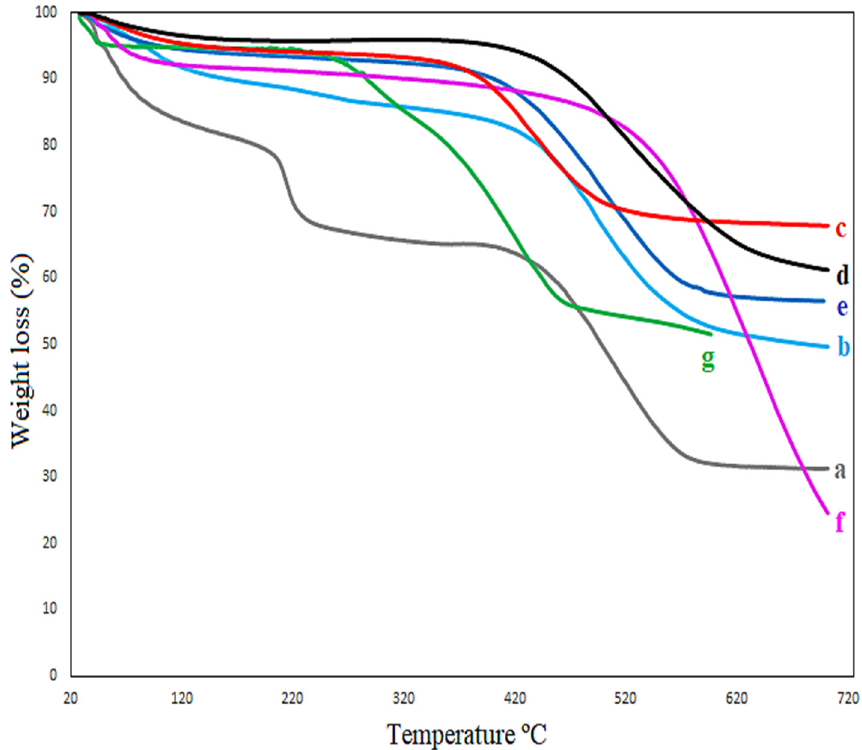
Figure 5. TGA analysis of activated carbon ( a ), Fe-C catalyst ( b ), Fe-C LT-FTS ( c ), Fe-C HT-FTS ( d ), Fe-C-K catalyst ( e ), Fe-C-K LT-FTS ( f ), and Fe-C-K HT-FTS ( g ).